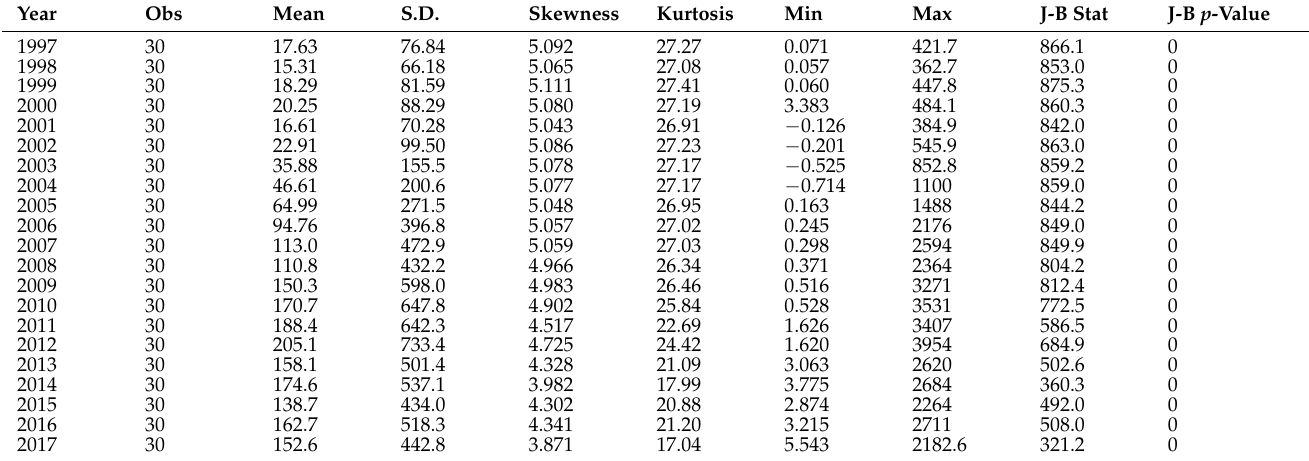
Table 3. The descriptive statistics of the intra-provincial carbon inequality measure.